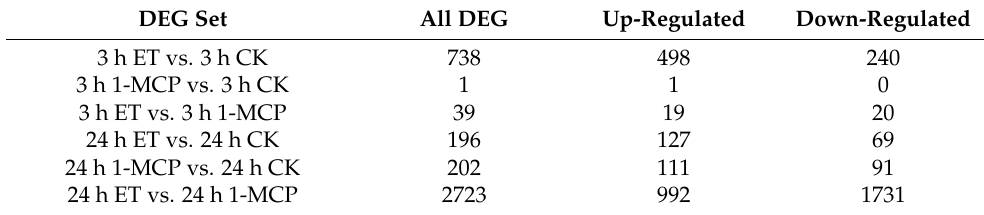
Table 1. Gene number statistics of different expression